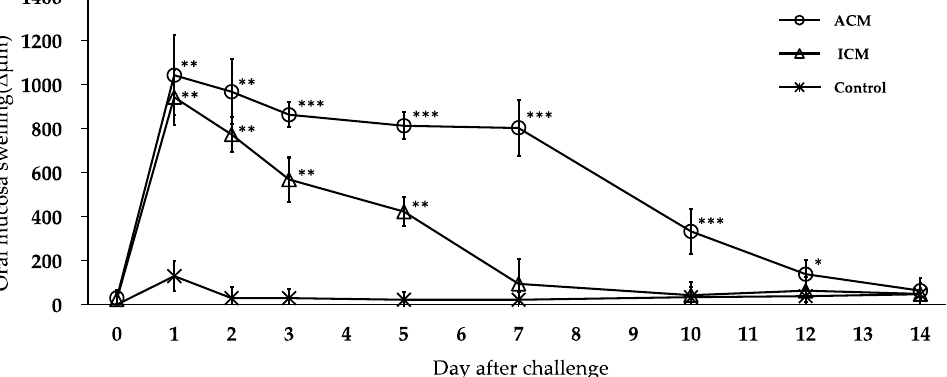
Figure 1. Swelling of the oral mucosa in Cr-induced allergic mice. The oral mucosa of all mice reached maximal swelling at Day 1 post-challenge. The oral mucosa swelled significantly more in the ACM mice from Days 1 to 12 post-challenge compared with the control mice. The bars and error bars represent the mean plus the standard deviation. The Kruskal–Wallis test was used to determine statistical significance, followed by Dunn’s multiple comparison tests (* p < 0.05, ** p < 0.01, *** p <